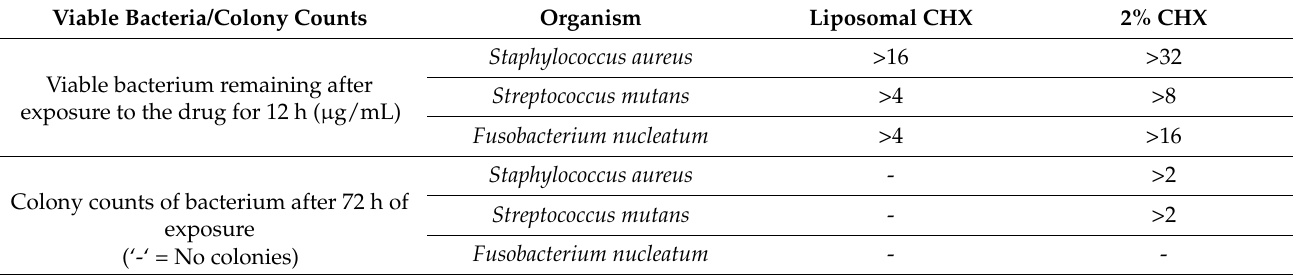
Table 4. Viable bacterial cells and colony forming units remaining after irrigation with liposomal CHX and 2% plain CHX.